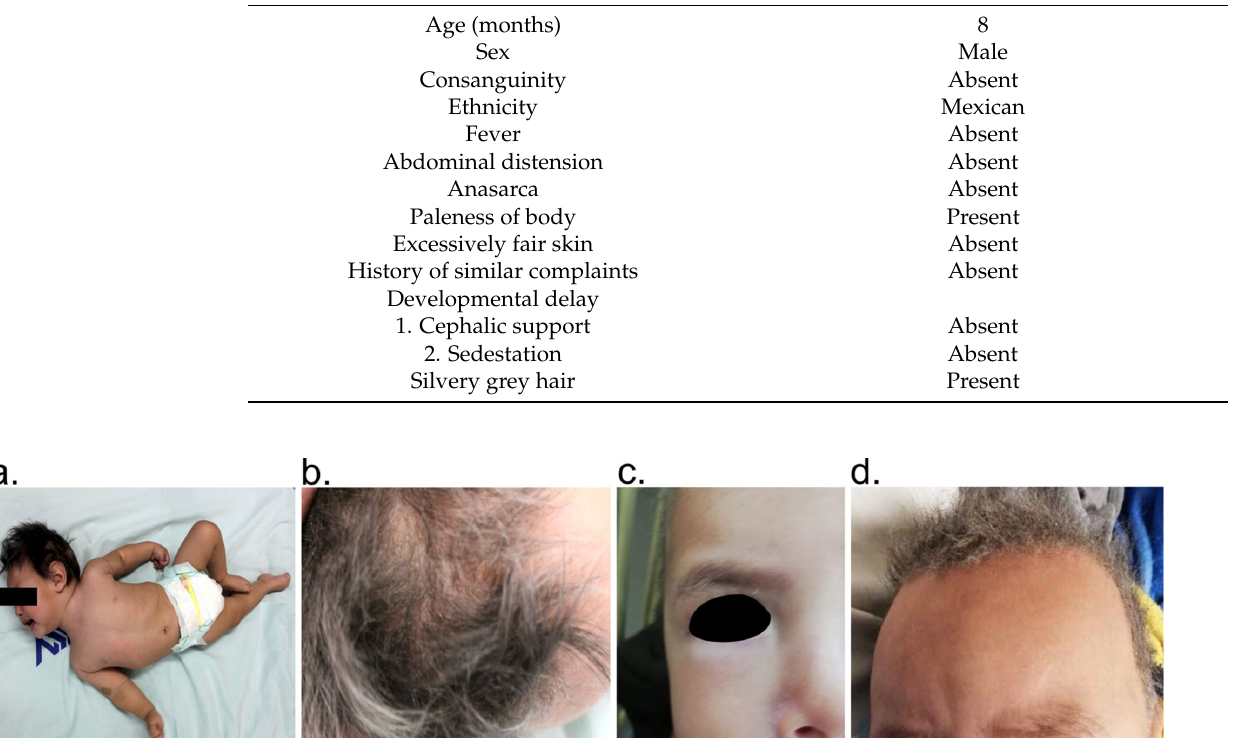
Table 2. Age-adjusted copper and ceruloplasmin values.